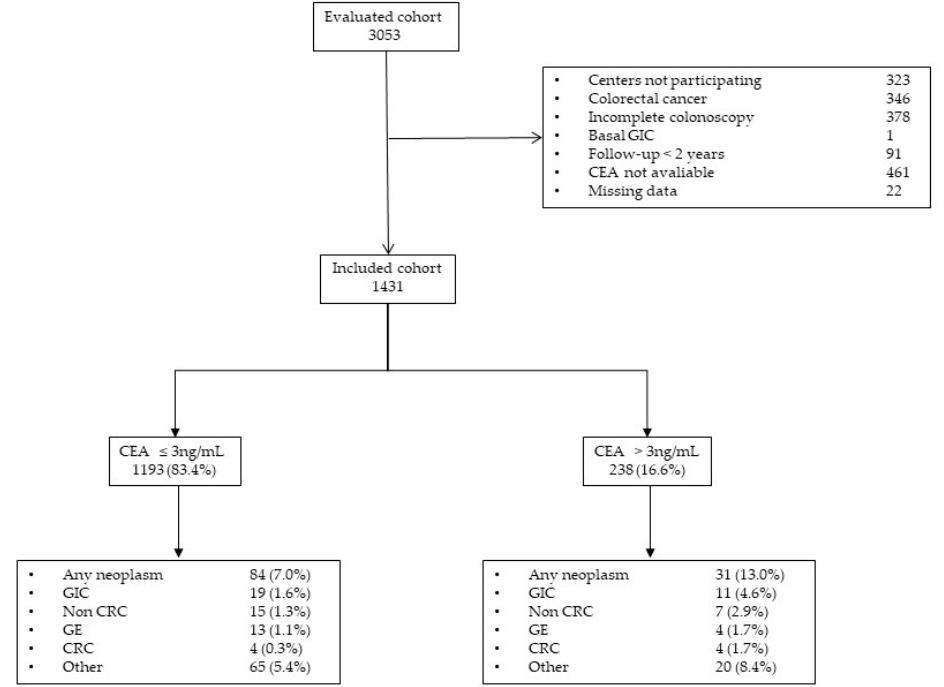
Figure 1. Study population flowchart. CEA = carcinoembryonic antigen; CRC = colorectal cancer; GE = gastroesophageal cancer; GIC = gastrointestinal